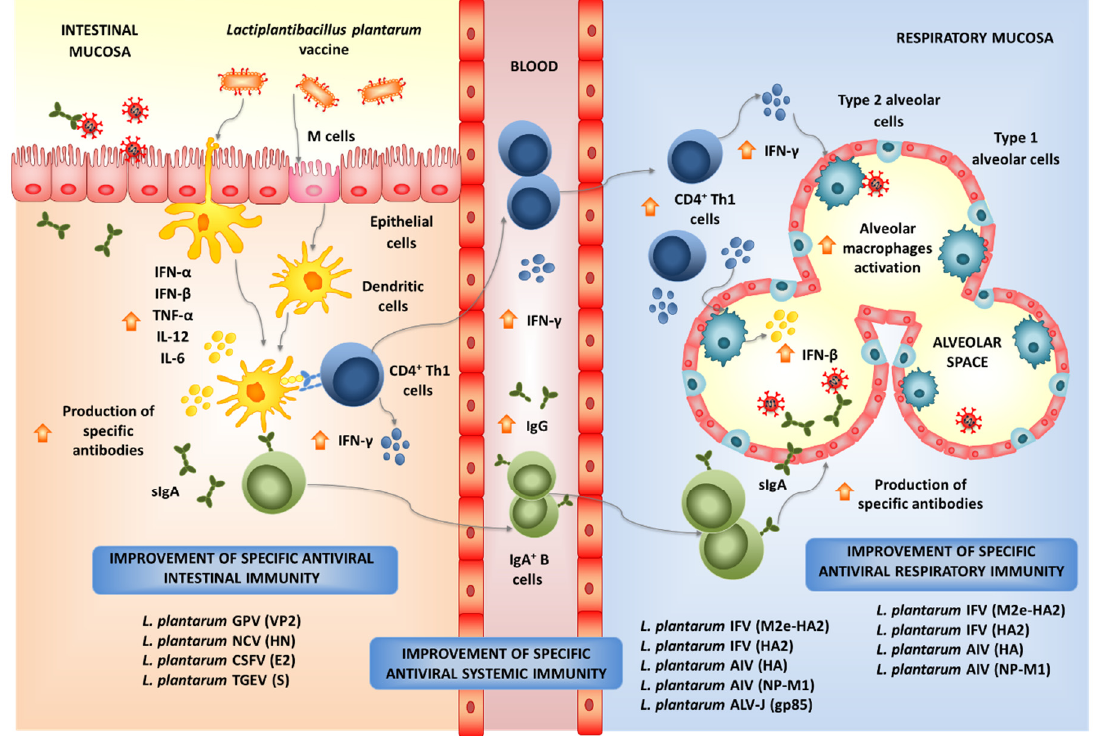
Figure 5. Beneficial effects of orally administered recombinant Lactiplantibacillus plantarum strains on the resistance and immune responses against virus in the intestinal and respiratory tissues.